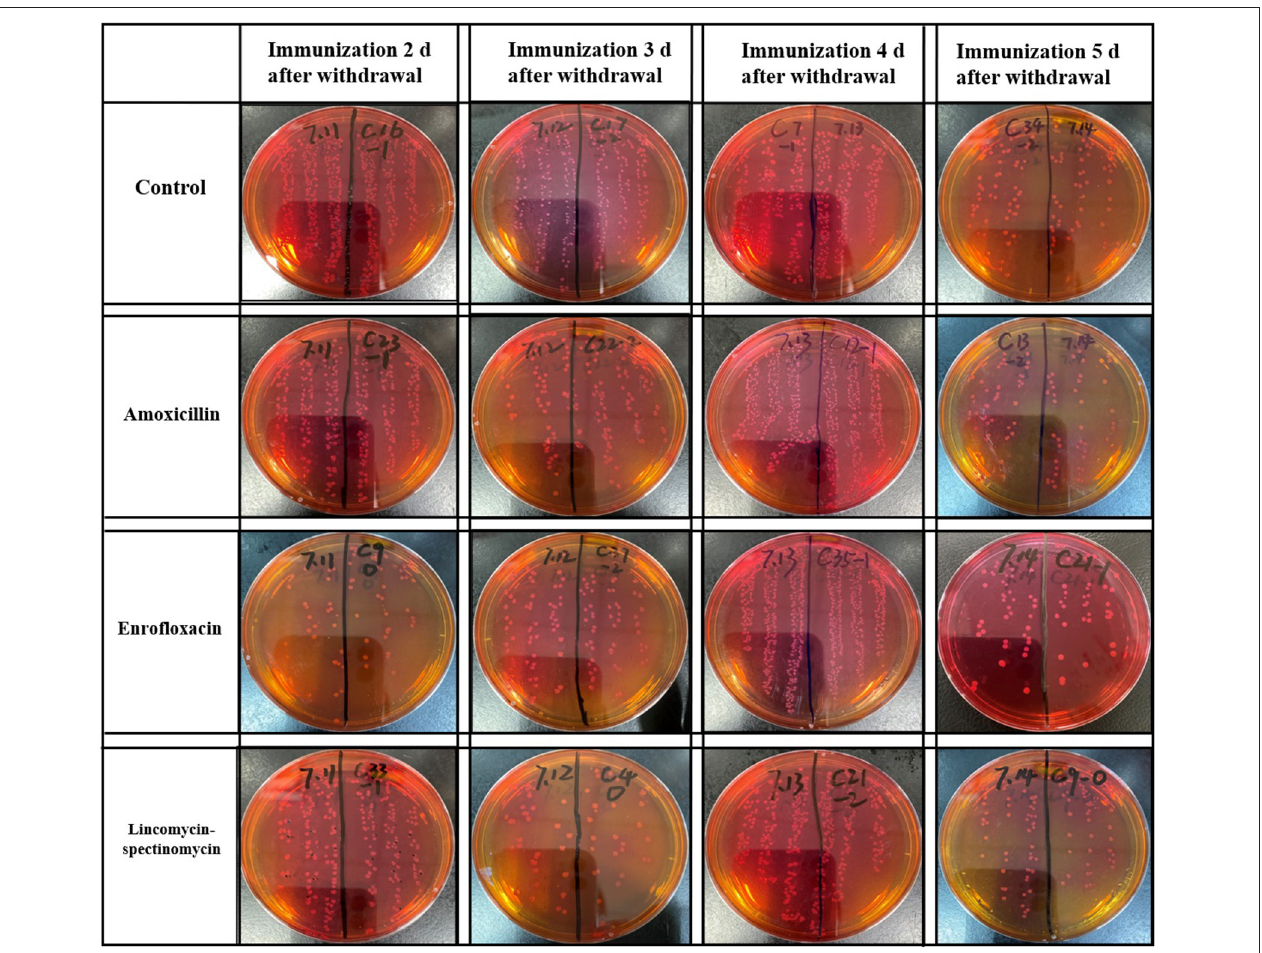
FIGURE 4 | Isolation of Salmonella from cecum in the amoxicillin, enrofloxacin, and lincomycin–spectinomycin groups. No matter how many days after withdrawal of antibiotics the chicks were immunized, the Salmonella vaccine strains isolated in the cecum of chicks were reddish smooth colonies on Brilliant-Green Phenol-Red Lactose Sucrose